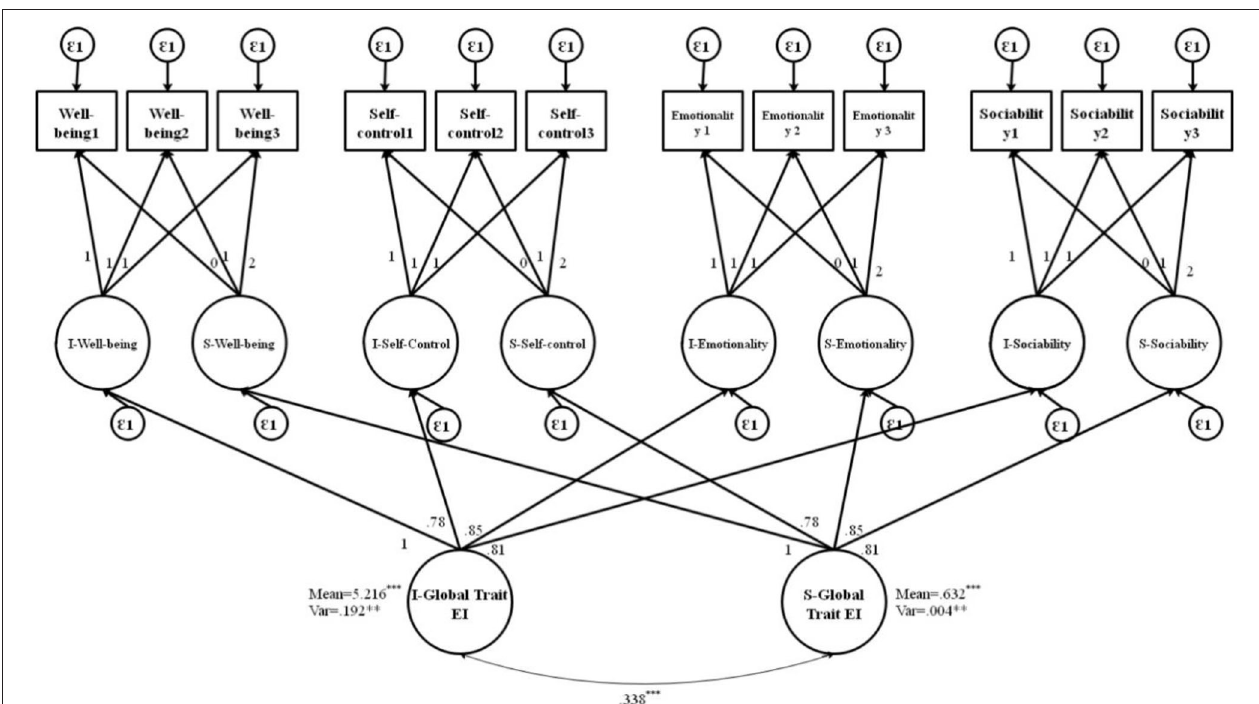
FIGURE 3 | Factor-of-curves model (FCM) of TEI. I, intercept; S, slope; TEI, trait emotional intelligence; WB, well-being; SC, self-control; EM, emotionality; SO, sociability; M, mean; Var, variance; ε = error; γ = factor loading [ χ 2 (df) = 236.84 (112), p < 0.001; CFI/TLI = 0.962/0.951; RMSEA = 0.051; SRMR = 0.055]; *** p < 0.001 ; ** p < 0.01.